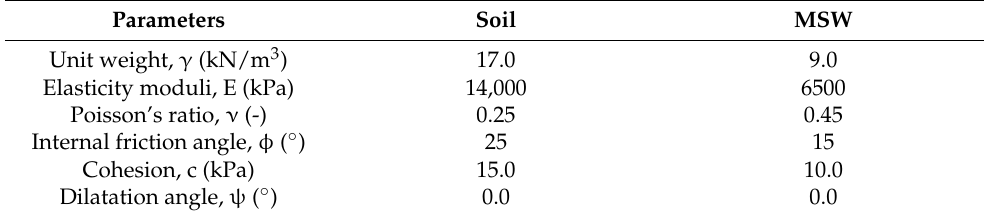
Table 1. MC model parameters.